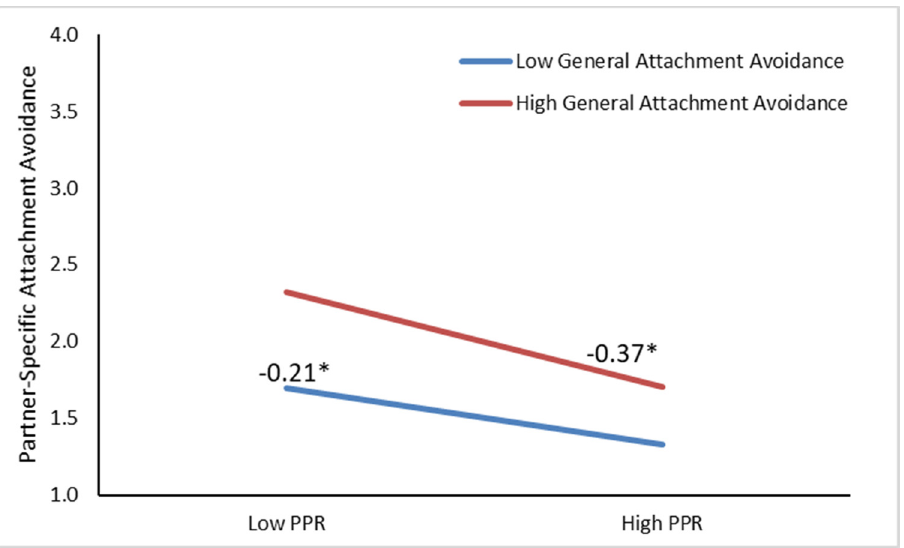
Figure 2. Predicting partner-specific attachment avoidance from perceived partner responsiveness as moderated by general attachment anxiety and controlling for partner-specific avoidance, age, sex, and study. PPR = Perceived Partner Responsiveness. * p < 0.05.